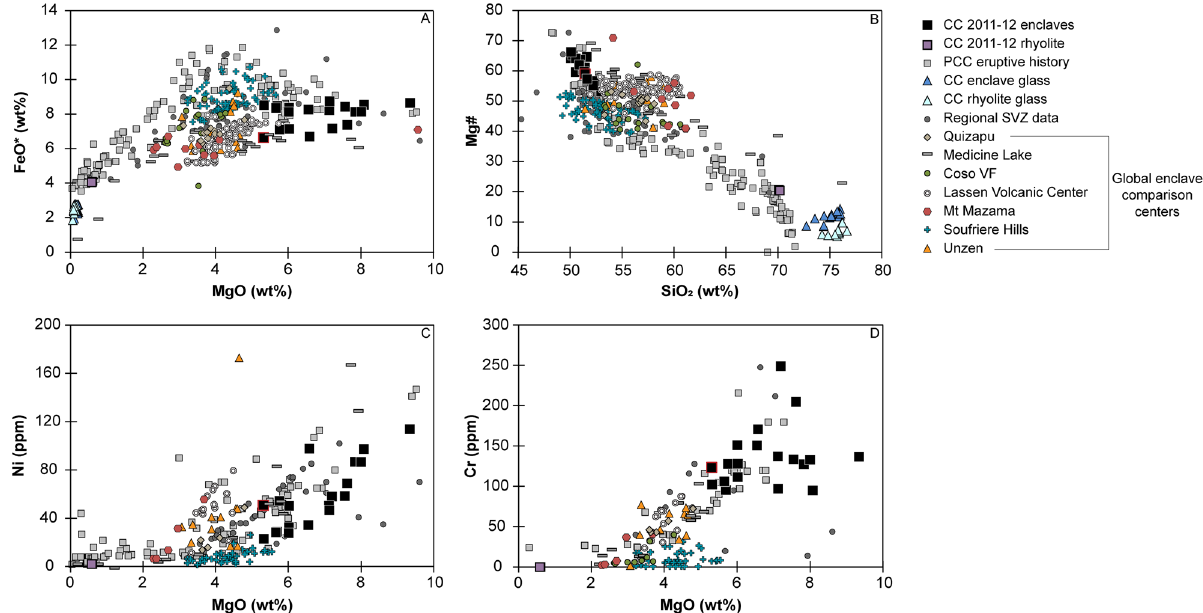
Figure 4. Global geochemical compilation of mafic enclaves (XRF data). 2011–12 CC enclaves are at primitive extent. CC: Cordón Caulle. Black square: 2011–12 CC coarsely-crystalline mafic enclaves. Black square with red outline: indicates porphyritic enclave population among CC enclaves. Purple square: 2011–12 CC rhyolite. Grey square: PCC eruptive history (EarthChem). Triangles: 2011–12 CC enclave and rhyolite glass (EMP data). Dk Grey circle: Regional SVZ data (EarthChem). Global enclave comparison centers: Quizapu, Medicine Lake, Coso VF, Lassen Volcanic Center, Mt Mazama, Soufriere Hills, Unzen. References for global centers in ESM